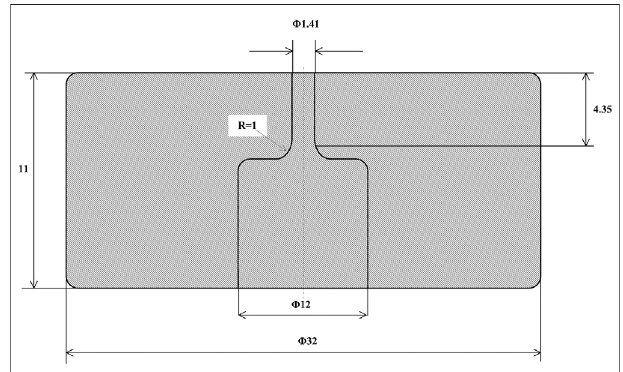
FIGURE 2 | Schematic of nozzle A in literature (Chen et al.,